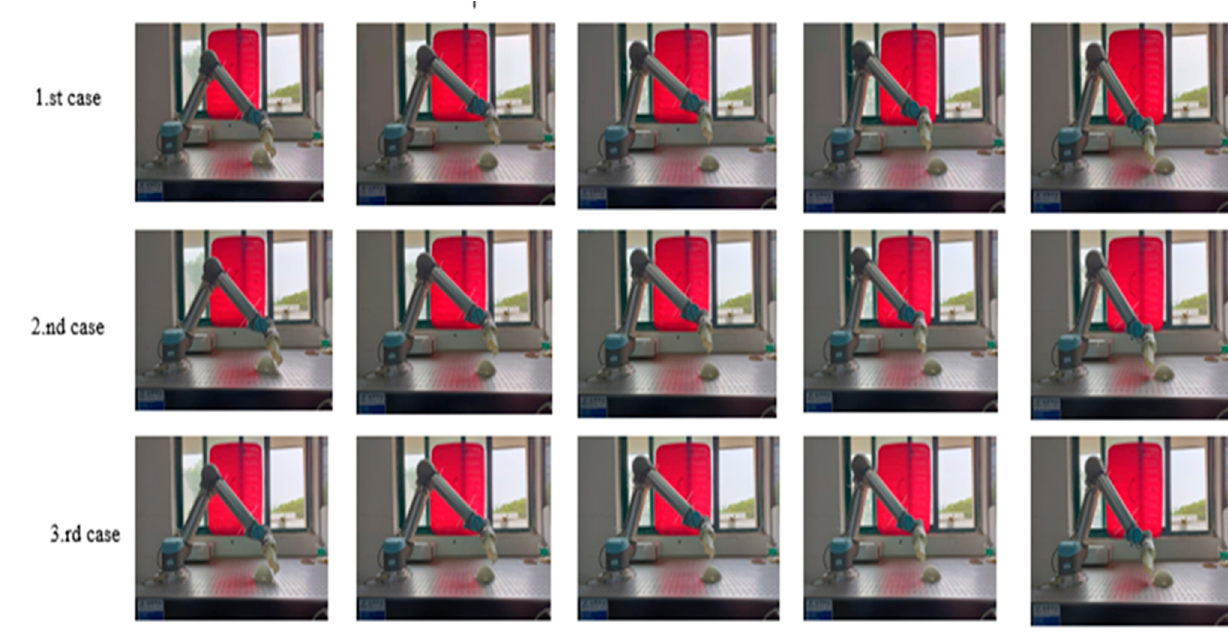
Figure 15. Trajectory of UR5 manipulator in three cases (PDC-PID controller, APF and with PDC-APF modified by DE).